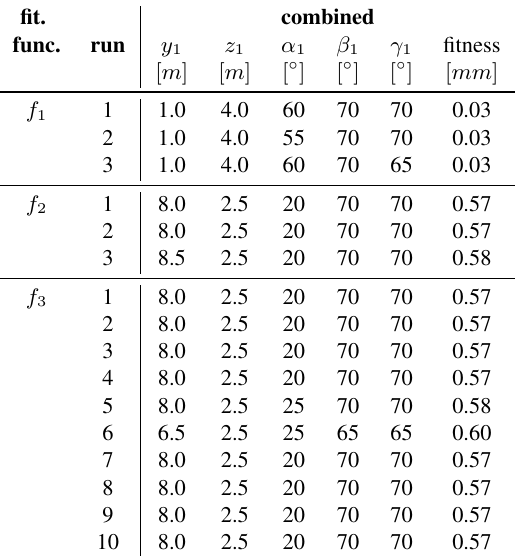
Table 6. Results of a combined optimisation of the RP translations and rotations (i.e. all five variables)